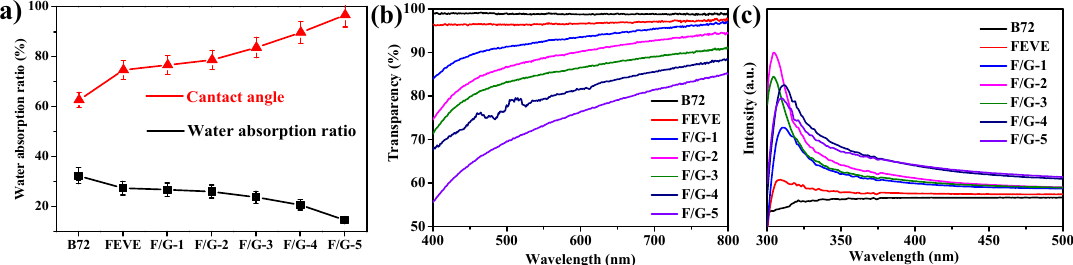
Figure 5. ( a ) Water absorption and contact angle of coating film. ( b ) Light transmittance of coating film. ( c ) UV absorption spectrum of coating film.